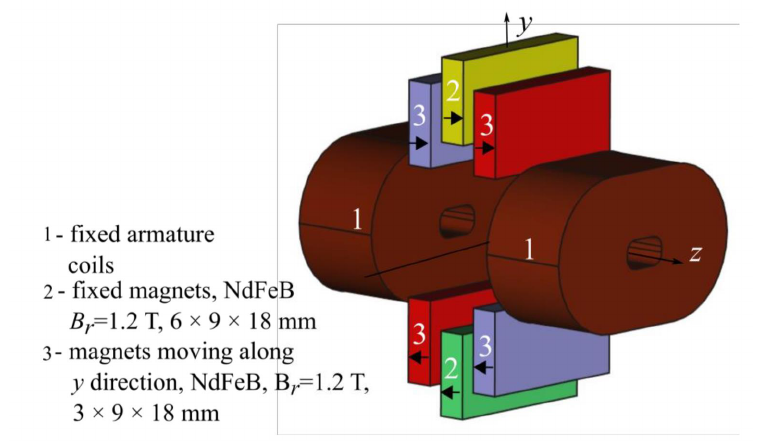
Figure 5. Magnets and coils from proposed harvester [52].